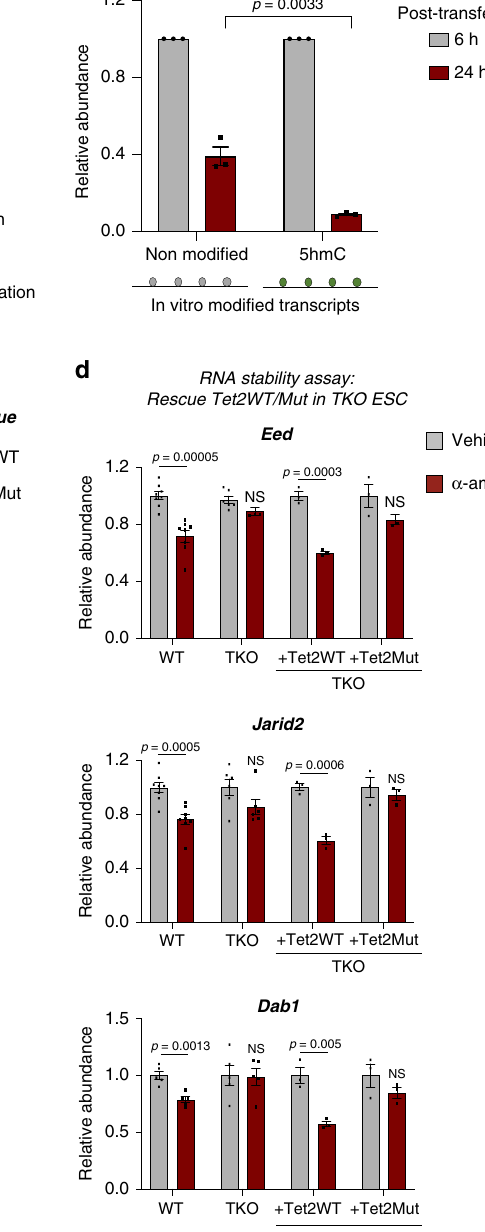
were signi fi cantly less stable in WT ESCs than in TKO ESCs.